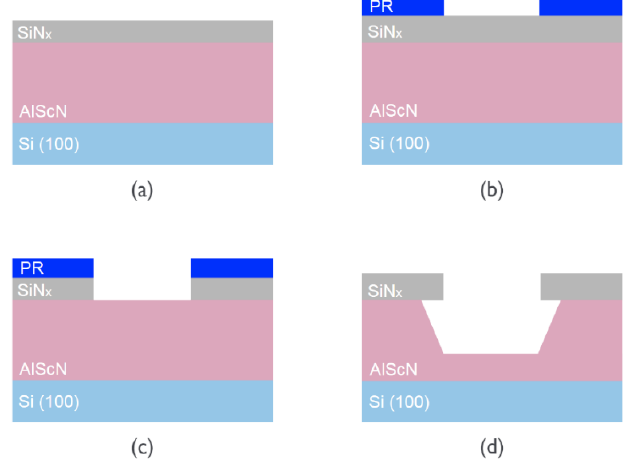
( b ) Figure 1. ( a ) AFM of the Al 0.64 Sc 0.36 N Film. ( b ) Rocking curve measurement (Omega Scan) of an Al 0.64 Sc 0.36 N film. 2.2. Film Patterning To selectively etch AlN/Al 1 − x Sc x N, the film must be patterned so that only locations of interest would be exposed in the etchant. Silicon nitride (SiN x ) was chosen as our hard mask, as it has an etch rate of 0.67 nm/min in 30% KOH at 80 °C [55], which is negligible compared to the etch rates of Al 1 − x Sc x N. A 200 nm SiN x film was deposited on top of the Al 1 − x Sc x N film in an Oxford Plasma Lab 100 Plasma-enhanced Chemical Vapor Deposition (PECVD) machine (Oxford Instruments Plasma Technology, Bristol, United Kingdom), and on the backside of the wafer as well to protect the Si substrate during the etch. After- wards, photoresist MICROPOSIT ® S1813 was spin-coated and exposed in a Karl Süss MA6 Mask Aligner (SÜ SS MicroTec SE, Garching, Germany) via contact lithography. The ex-